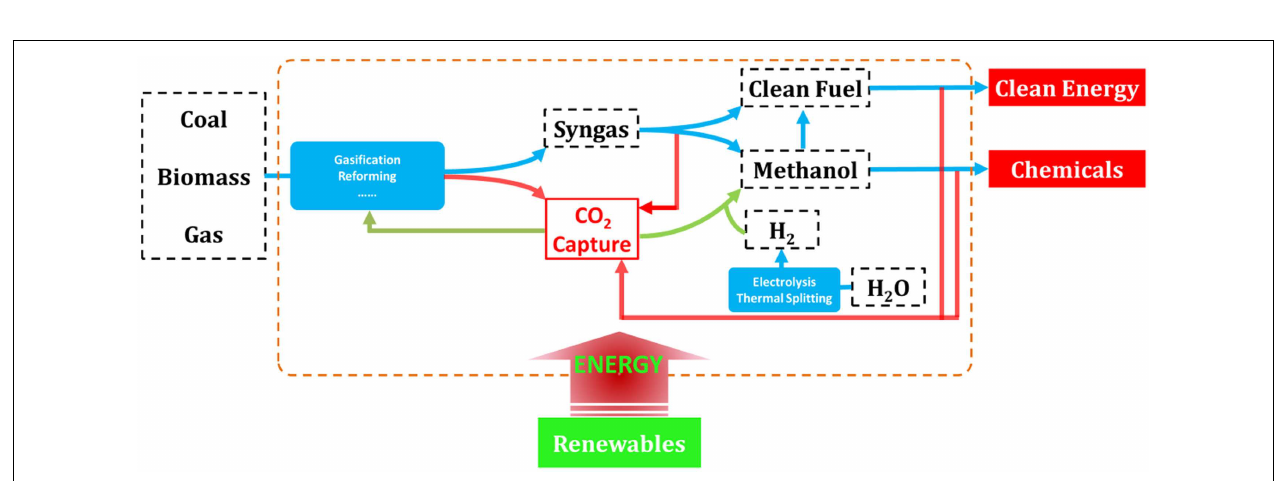
FIGURE 2 |An integrated energy–chemical solution with CO 2 capture